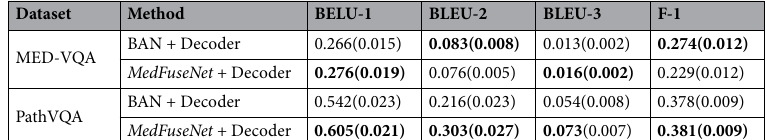
Table 6. Comparison of MedFuseNet with the baseline models on answer generation dataset.